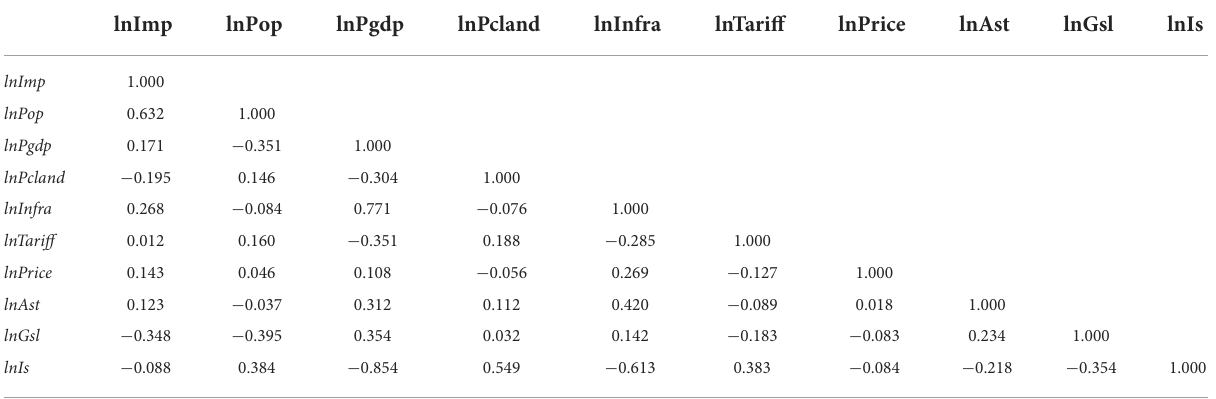
TABLE 2 Correlation coefficient matrix between variables.